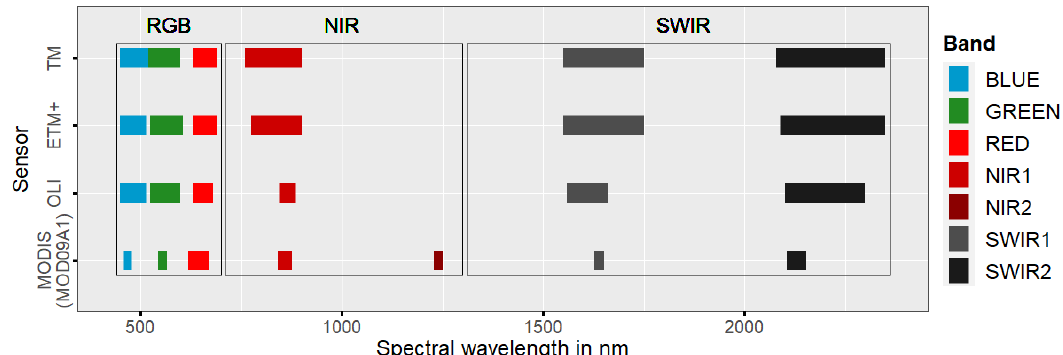
Figure A1. Mean scPDSI of the Steigerwald. More recent years feature significantly lower scPDSI values.